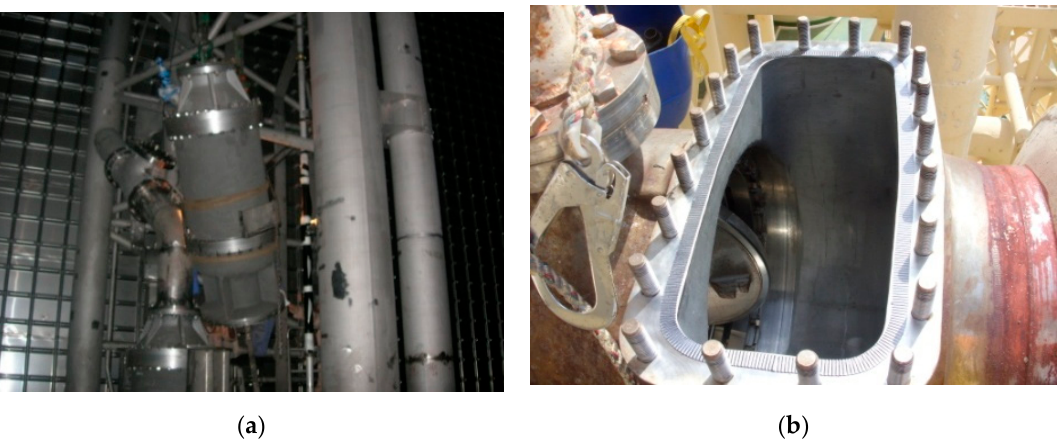
Figure 1. Examples of liquefied natural gas (LNG) cargo containment system maintenance tasks during dry docking. ( a ) Detaching a cargo pump in an LNG cargo tank for an overhaul inspection. The inside of the LNG cargo tank should be prepared as a nonhazardous working environment after inerting, warming, and aerating. ( b ) Butterfly LNG cargo valve inspection after inerting, warming, and aerating for safe repair.